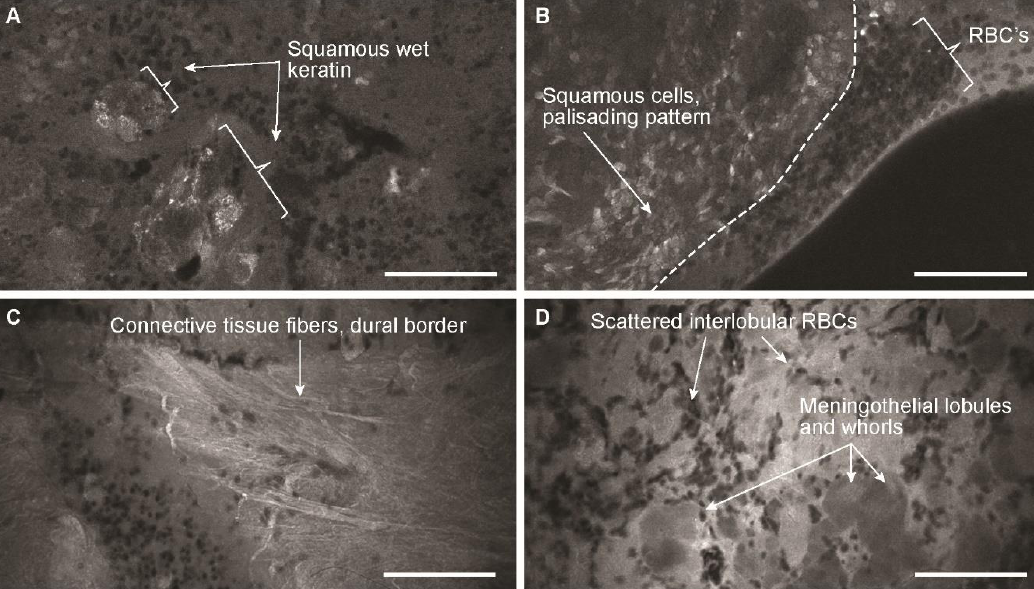
Figure 6. Confocal laser endomicroscopy (CLE) images of ( A , B ) craniopharyngioma and ( C , D ) meningioma. Bars = 100 μm. RBCs, red blood cells. Used with permission from Barrow Neurological Institute, Phoenix, Arizona.